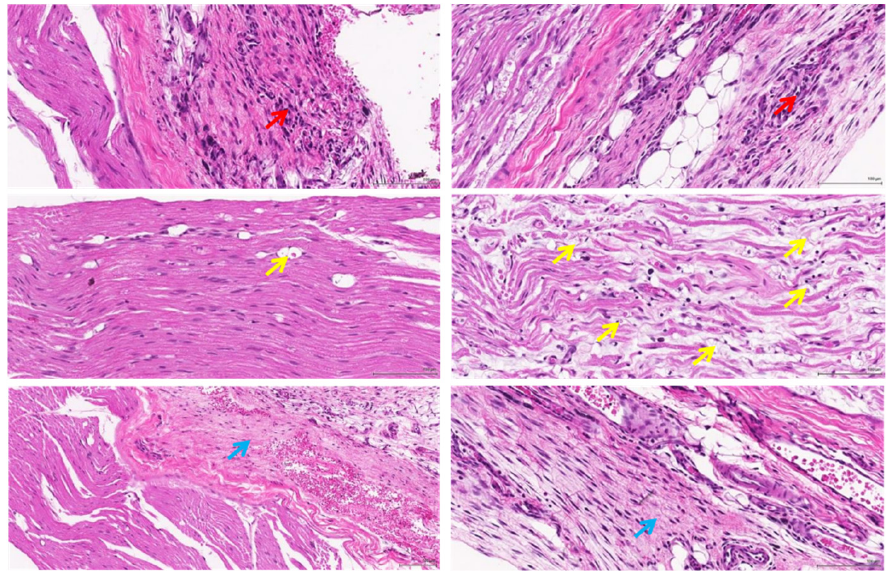
Figure 9. There is moderate inflammation and fibrosis present and mild axonal degeneration at the grip sites by the haemostats: (Histopathological findings at D13, 20×, H&E, Inflammatory cell infiltrate (red arrow), Axonal degeneration (yellow arrow), Fibrosis (blue arrow)).